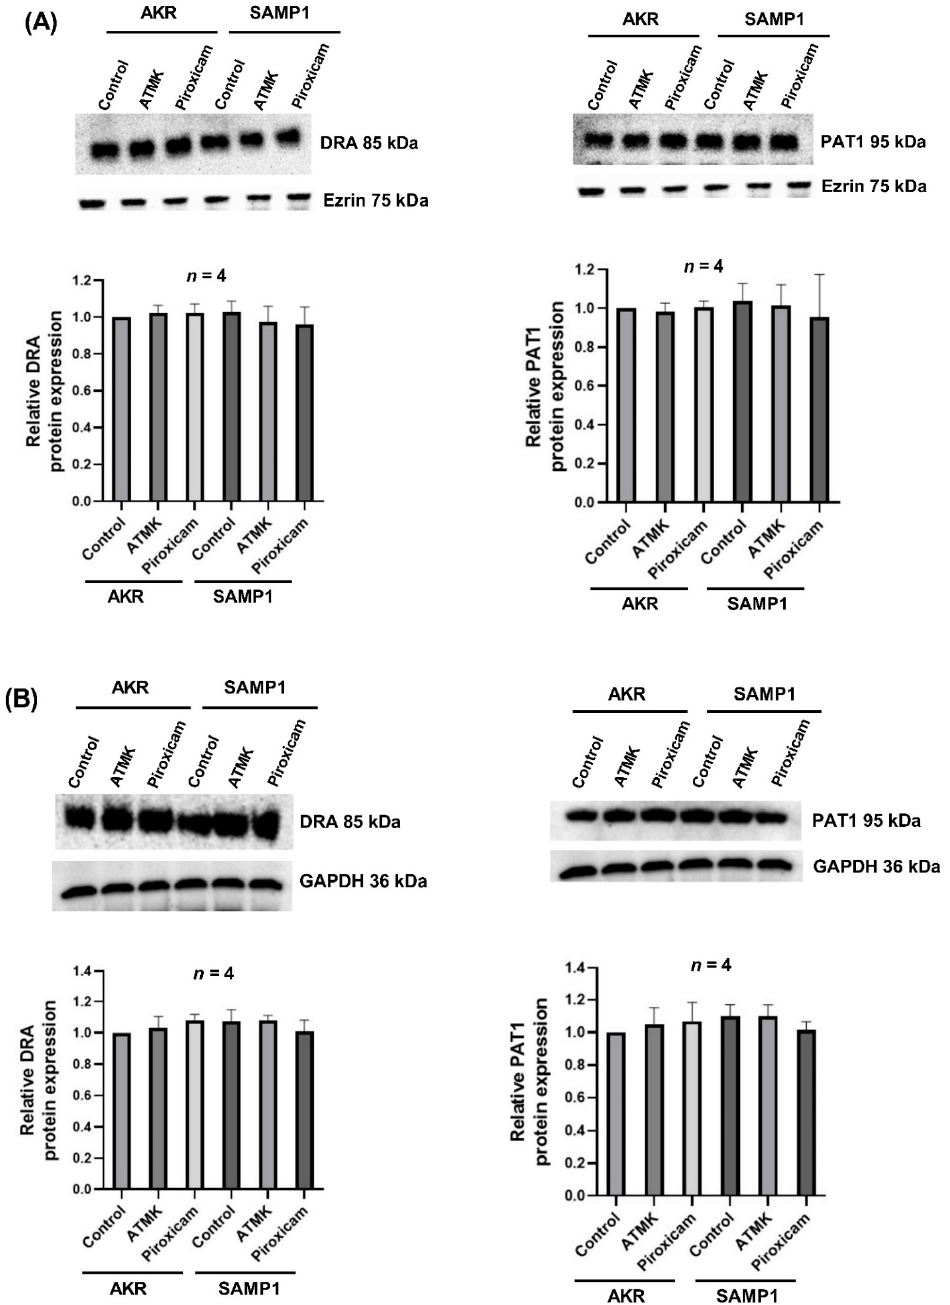
Figure 6. Protein levels of the BBM Cl − /HCO 3 − exchangers (DRA and PAT1) are not altered in SAMP1 mice. Protein samples prepared from ( A ) BBM or ( B ) cellular homogenate protein preparations from AKR and SAMP1. SAMP1 treated with